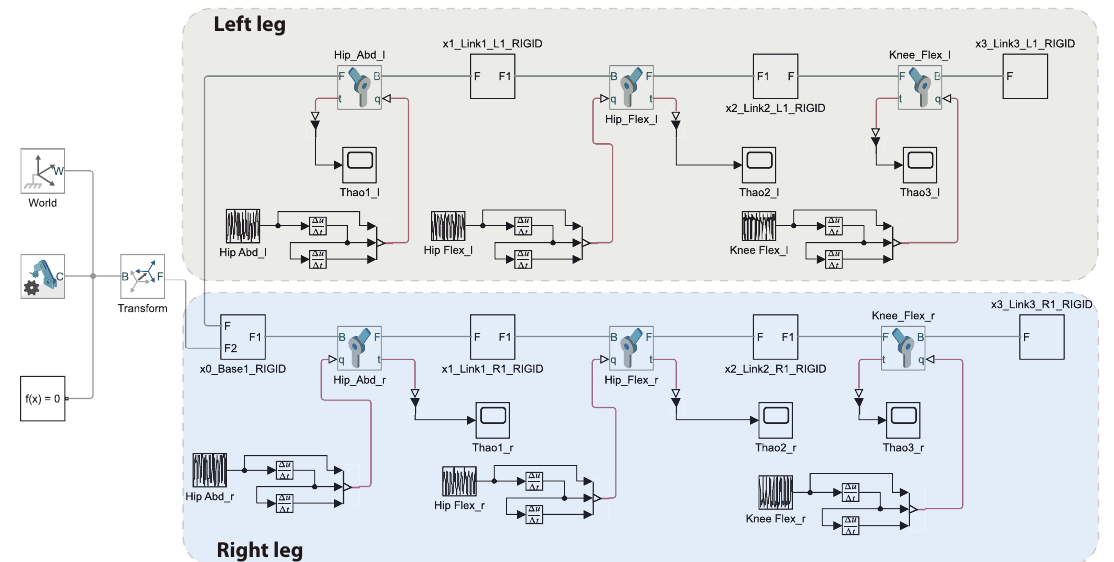
Figure 3. ALICE, Simulink R (cid:13) , Simscape Multibody TM equivalent model.